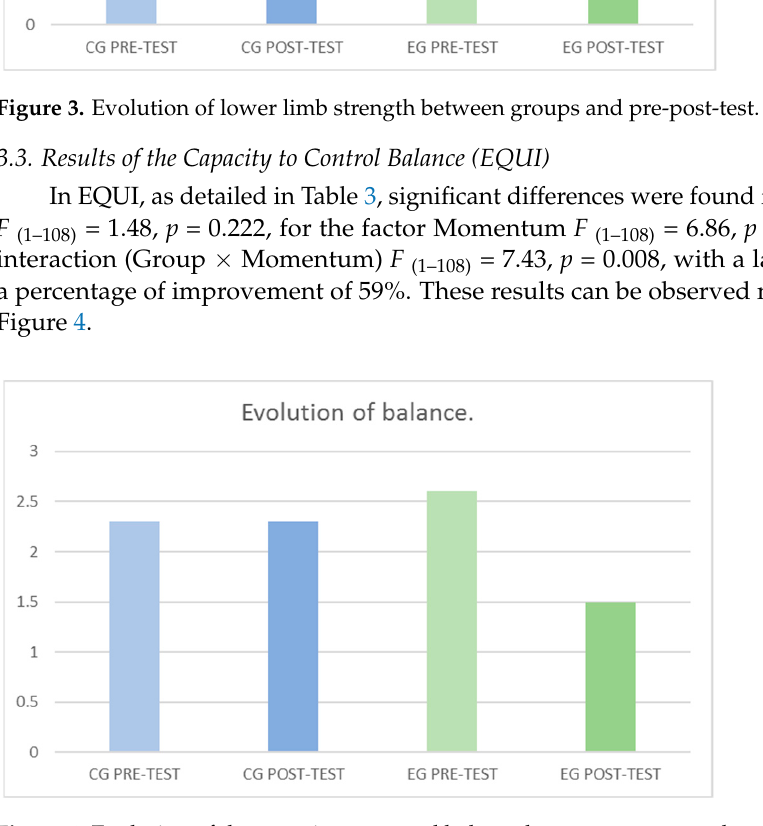
Figure 4. evolution of the capacity to control balance between groups and pre-post-test.